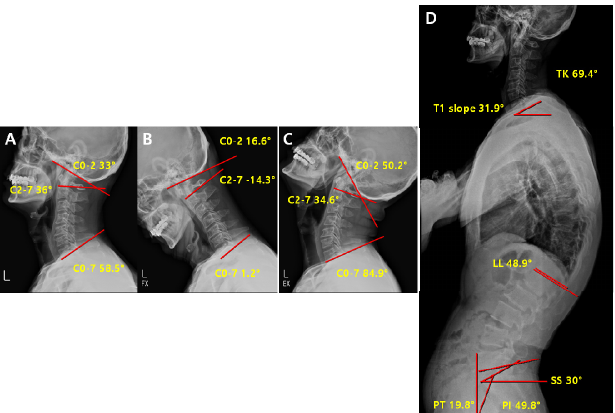
Figure 6. Pre-operative radiological parameters in lordosis groups. Cervical spine lateral X-ray of neutral ( A ), flexion ( B ), and extension ( C ), and whole-spine lateral X-ray ( D ). C0-2; C0-2 Cobb angle, the occipito-cervical angle, which is the intersection angle between the McGregor line and the line parallel to the C2 lower endplate. C2-7; C2-7 Cobb angle, the intersection angle between the line perpendicular to the line parallel to the C2 lower endplate and the line perpendicular to the line parallel to the C7 lower endplate. C0-7; C0-7 Cobb angle, the intersection angle between the McGregor line and the line parallel to the C7 lower endplate. TK; thoracic kyphosis, intersection angle between the line perpendicular to the line parallel to the T1 upper endplate and the line perpendicular to the line parallel to the T12 lower endplate. LL; lumbar lordosis, intersection angle between the line perpendicular to the line parallel to the L1 upper endplate and the line perpendicular to the line parallel to the L5 lower endplate. SS; sacral slope, the angle formed by a line drawn along the endplate of the sacrum and a horizontal reference line. PT; pelvic tilt, the angle formed by a line drawn from the midpoint of the sacral endplate to the center of the bicoxofemoral axis and a vertical plumb line. PI; pelvic incidence, the angle formed by two vectors: the line joining the bicoxo-femoral axis to the center of the sacral end plate and the line perpendicular to the sacral endplate.